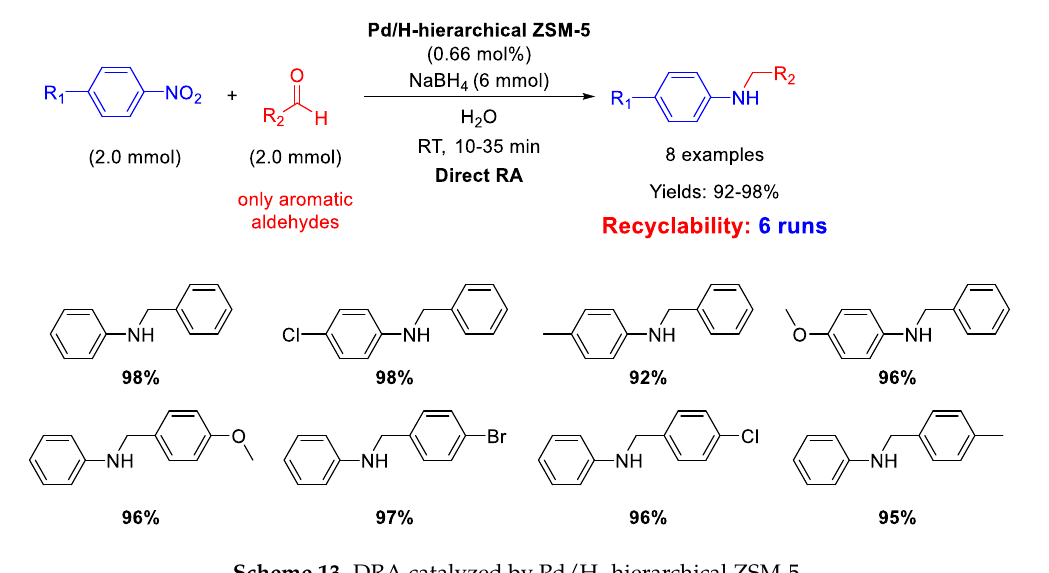
Scheme 13. DRA catalyzed by Pd/H- hierarchical ZSM-5.